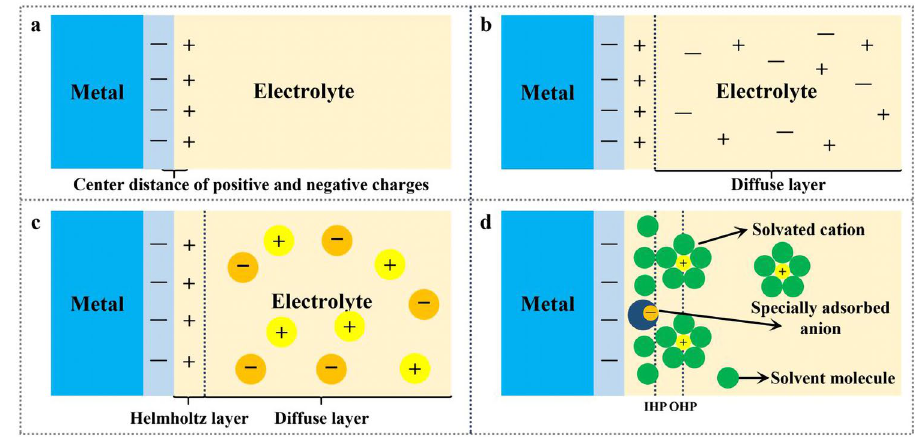
Fig. 3 a Helmholtz model, the distance between positive and negative charges is a definite data; b Gouy–Chapman model considering diffuse layer, the distance between positive and negative charges is a variable; c Gouy–Chapman–Sternsilver model, ions have dimensions; d Electric double layer structure involving cation